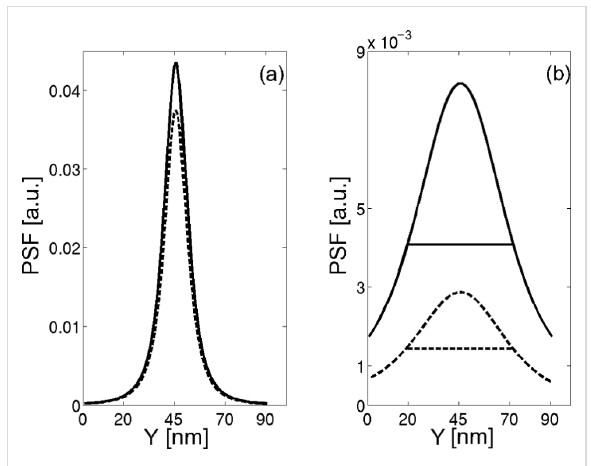
Figure 2: One dimensional PSF calculated for two different probe–sample distances with and without the cantilever, represented by the dashed and solid lines respectively. The model with the tip only uses β = 0° (normal to the surface) while the other one uses β = 10°. (a) Tip–sample distance of 1.2 nm, (b) tip–sample distance of 17.8 nm. The horizontal lines in (b) represent the FWHM for a probe–sample distance of 17.8 nm. The simulations were performed using W = 40 μ m.